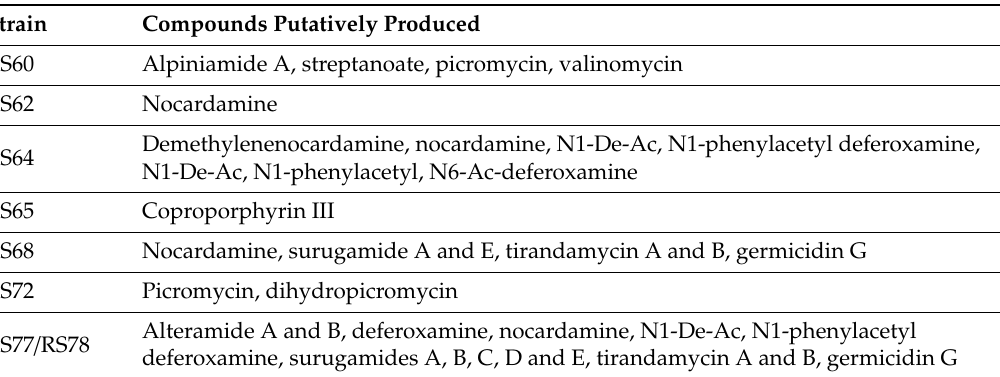
Table 2. Molecules produced by seven isolated